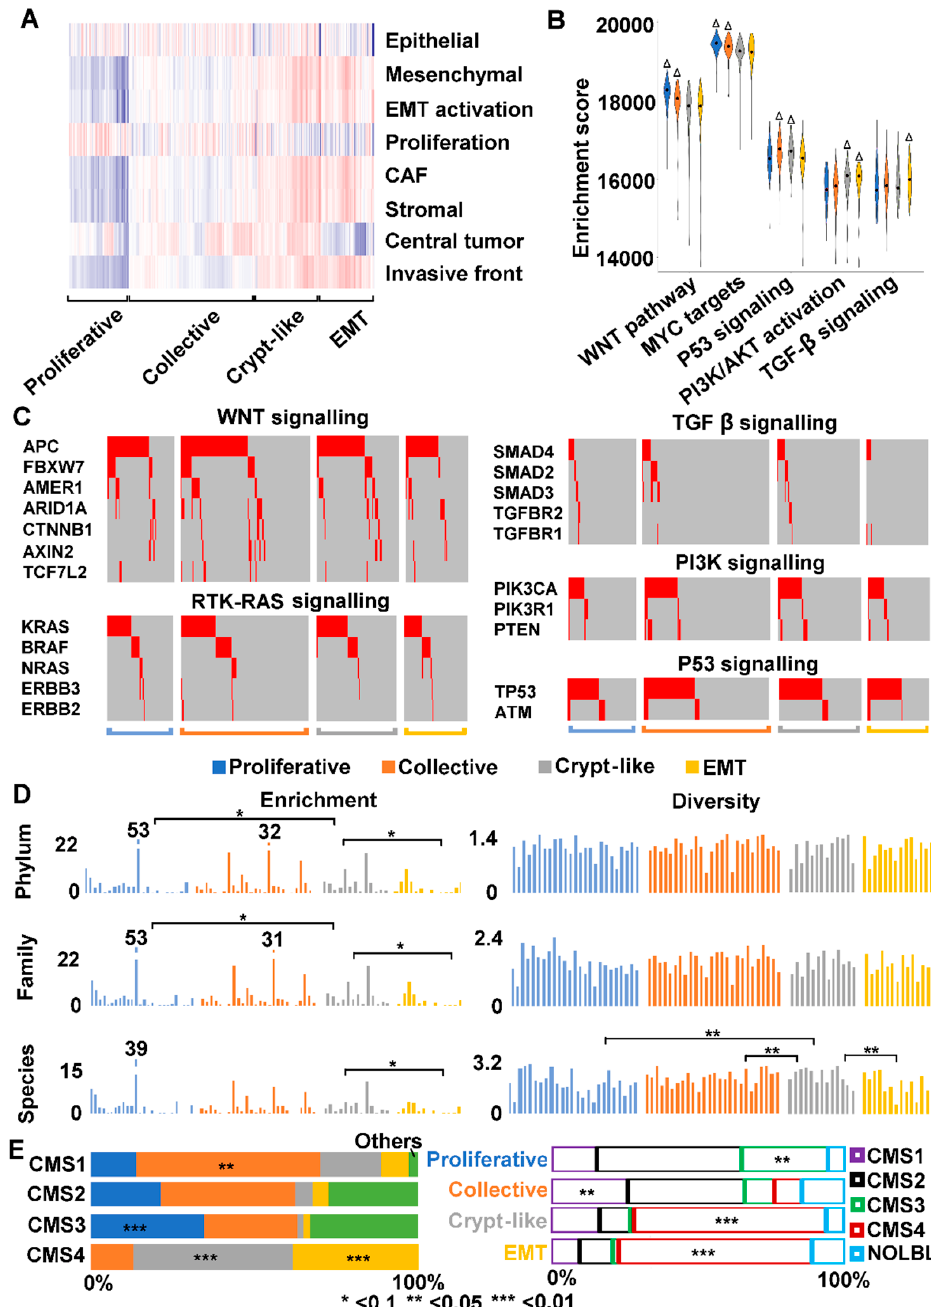
Figure 6. We have classified TCGA colon cancers and found that consensus molecular subtype 4 (CMS4) consists of crypt-like and EMT invasion cancers. ( A ) TCGA colon cancers (379 out of 478 total) were classified into four subtypes, with their ssGSEA enrichment scores of signatures indicated by the heatmap. Red: enriched; blue: depleted. ( B ) The four subtypes differ in canonical CRC pathways, as indicated by the distribution of ssGSEA enrichment scores represented by the violin plot. ∆ : significant activation. ( C ) TGF- β signaling genes are less frequently mutated in EMT invasion compared to other subtypes. Each column represents a tumor sample, and only driver mutations (red) are shown. ( D ) EMT tumors overall harbor fewer bacteria, compared to tumors of other subtypes. ( E ) CMS4 can be further divided into crypt-like invasion and EMT invasion subtypes. Left bars indicate the distribution of our subtypes among the CMS subtypes, while right bars indicate the opposite. Others: not classified by us; NOLBL: no label (not classified [25]). See also Figure S5 and Table S6.